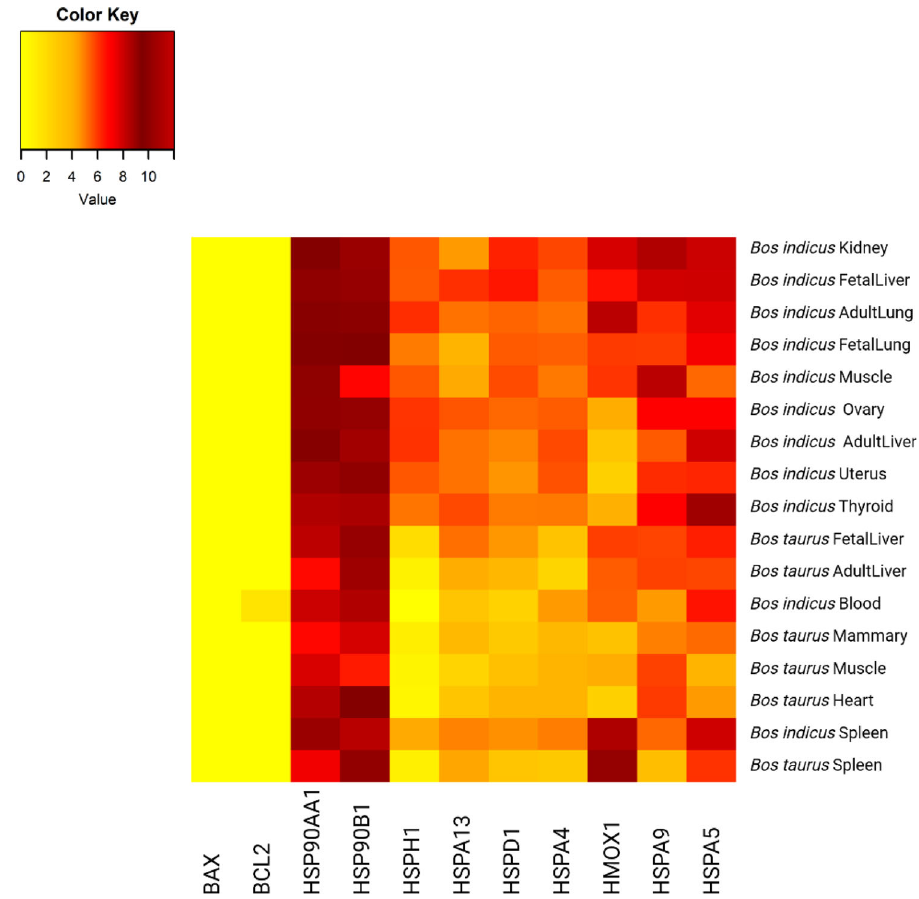
Fig. 5 Consensus TSS cluster expression in genes related to heat stress across the Bos taurus tissues (heart, adult and fetal liver, mammary, muscle, and spleen) and the Bos indicus tissues (blood, spleen, thyroid, adult and fetal liver, adult and fetal lung, kidney, muscle, uterus, and ovary). Log2 Tag per million (TPM) read was used as a measure of the expression level of RNAs in each